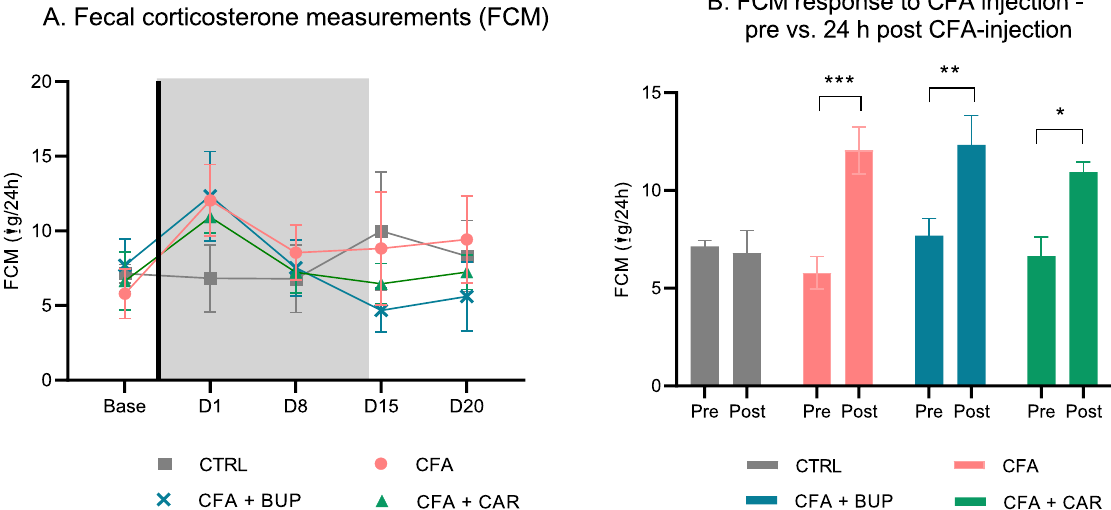
Fig 7. Faecal corticosterone measurements. (A) Faecal corticosterone metabolites (FCM) measurements are displayed as μ g/24 h at baseline and D2, D9, D16 and D21. (B) Pre (baseline measurements) -and post-CFA-injection (D2 measurements) are compared. The asterisk represents statistical significant difference at � p < 0.05, �� p < 0.01 and ��� p < 0.001. For all data: presented as mean ± SEM. For all graphs: base = baseline values, D = day, the line represents the day of analgesic treatment initiation (D0) and the grey area represents the treatment period (15 days). For all groups: n = 8, male Sprague Dawley rats.